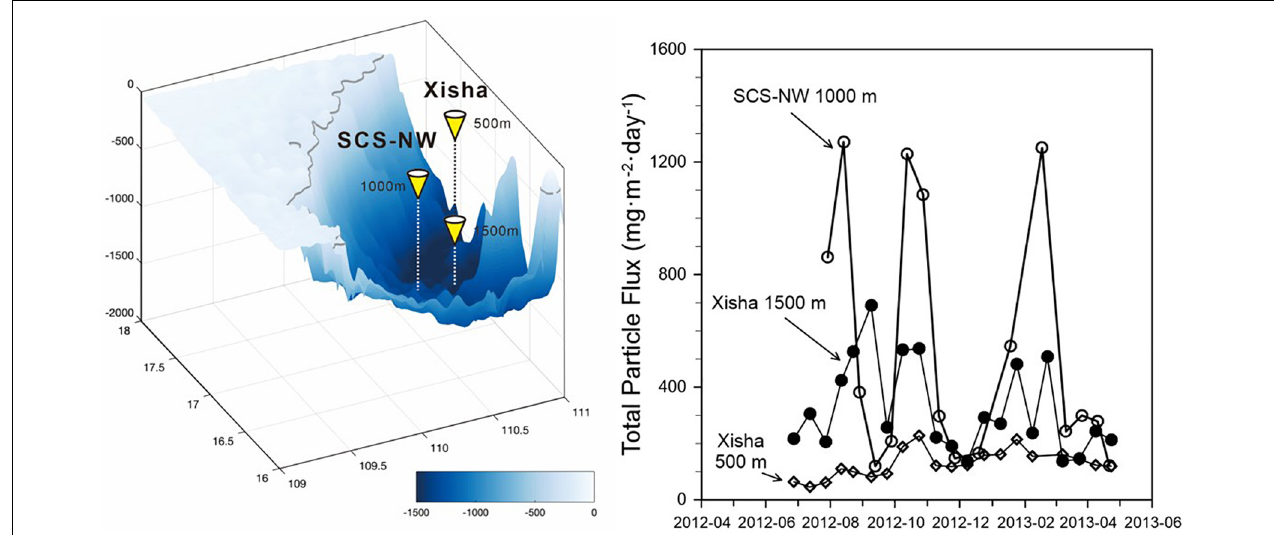
FIGURE 8 | Sketched map of the SCS-NW and Xisha sediment trap moorings and comparison of the total particle fluxes at different depths between the two trap